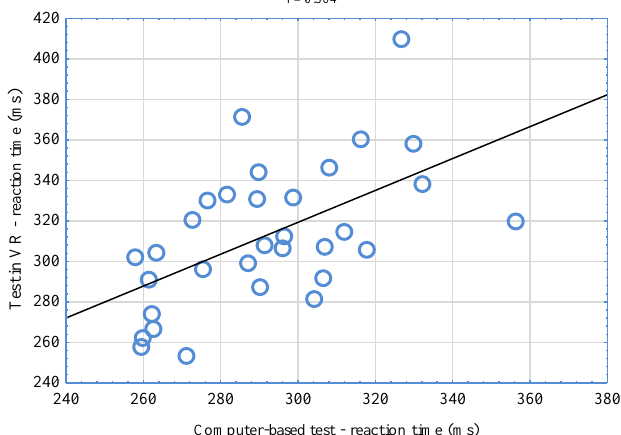
Figure 7. Correlation of the results of simple reaction tests in VR and computer-based ones — left hand.